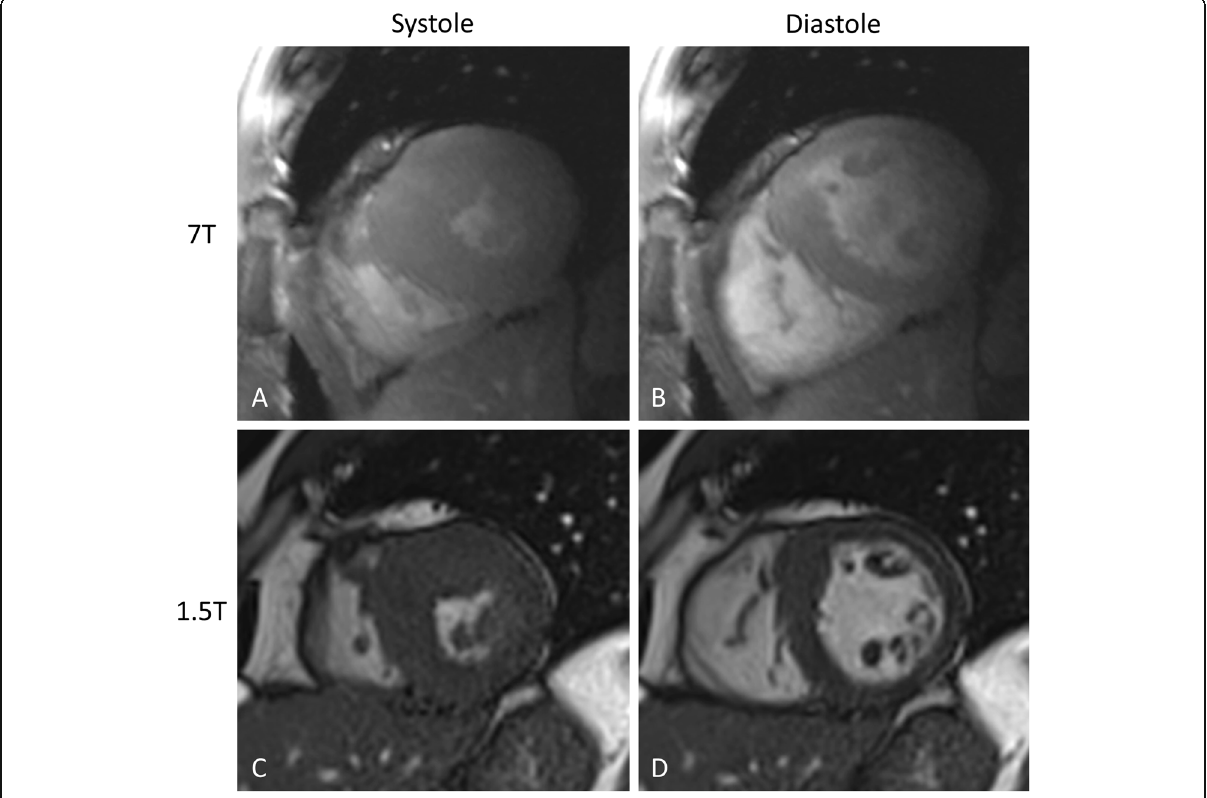
Fig. 4 Systolic and diastolic cine images acquired at 7 T ( A, B ) and 1.5 T ( C, D ) in the same subject. Despite the challenges with electrocardiography interference and triggering, diagnostic quality cine images can be acquired with high temporal and spatial resolution. Figure courtesy of Dr. Harold I. Litt, University of